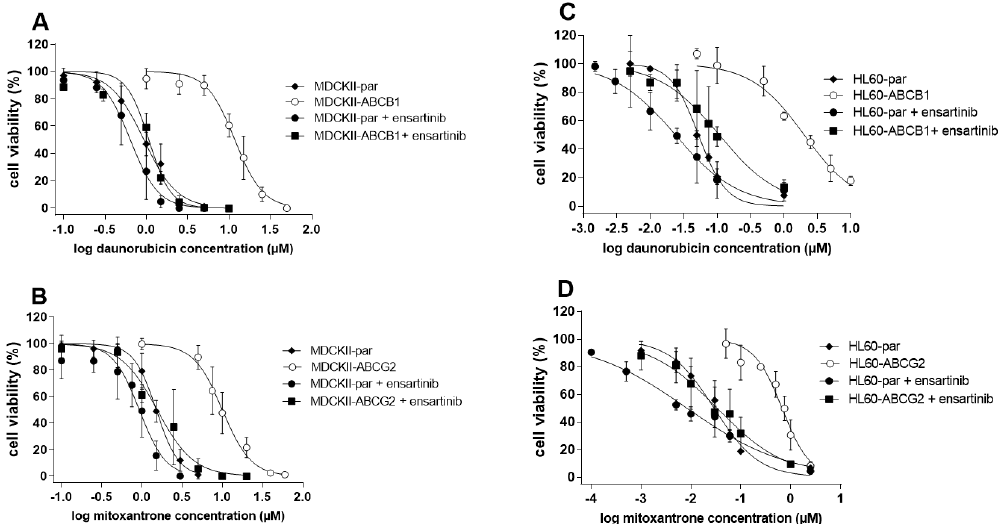
Figure 6. Effect of the combination of 10 µM ensartinib with daunorubicin or mitoxantrone in Figure 6. E ff ect of the combination of 10 µ M ensartinib with daunorubicin or mitoxantrone in MDCKII-ABCB1/HL60-ABCB1 ( A , C ) or MDCKII-ABCG2/HL60-ABCG2 ( B , D ) cells, respectively. MDCKII-ABCB1 / HL60-ABCB1 ( A , C ) or MDCKII-ABCG2 / HL60-ABCG2 ( B , D ) cells, respectively. Drug-induced e ff ects detected in the parental cell lines are shown for each variant. Cells were exposed to daunorubicin or mitoxantrone either alone or in combination with ensartinib for 48 h, after which cell viability was measured by the MTT method. The presented data are means ± SD for at least three independent